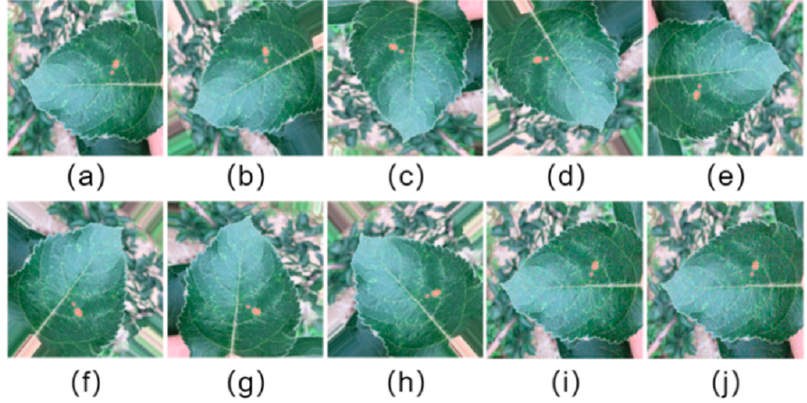
Figure 4. Examples of dataset augmentation: ( a ) original image; ( b ) rotated 45°; ( c ) rotated 90°; ( d ) rotated 135°; ( e ) rotated 180°; ( f ) rotated 225°; ( g ) rotated 270°; ( h ) rotated 315°; ( i ) salt-and-pepper noise; ( j ) Gaussian noise.